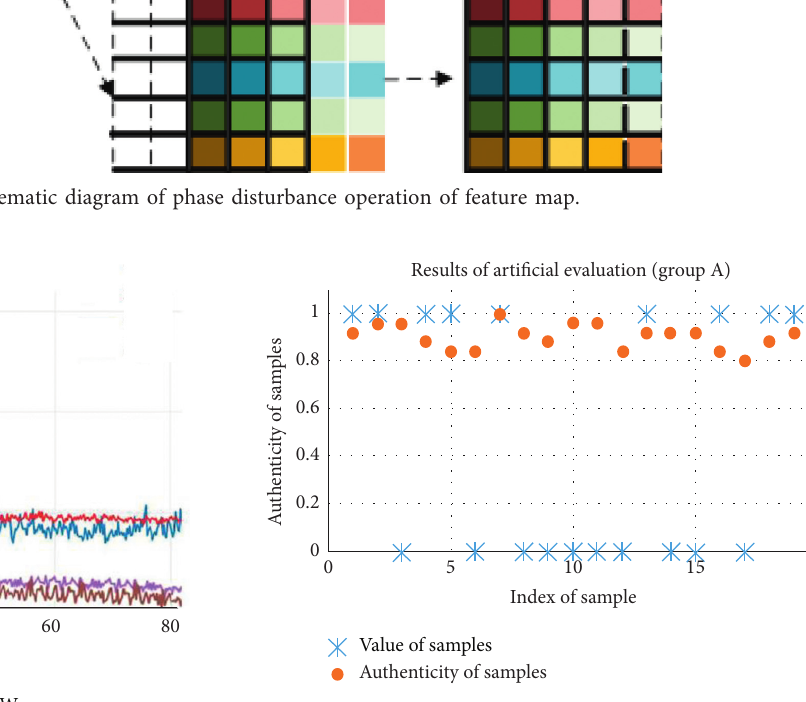
Figure 6: Qualitative evaluation results for Group